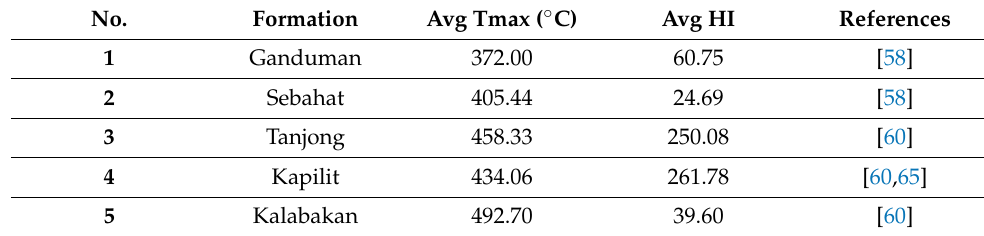
Table 10. Average Tmax and HI values of formations in